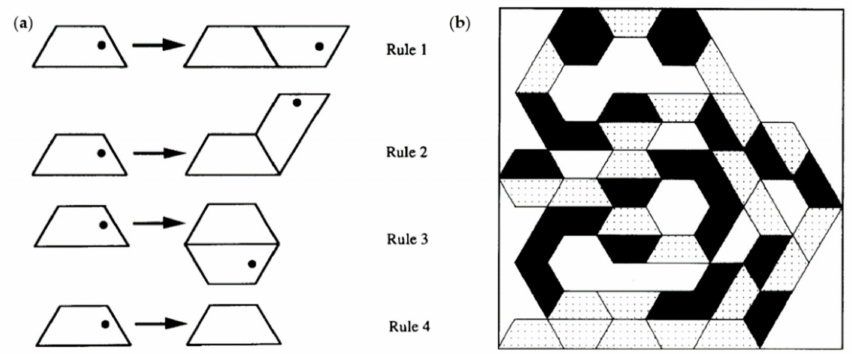
Figure 2. Snake-like shape grammars of half-hexagons: ( a ) Four simple shape grammar rules consisting of half-hexagons with a long base of one unit and a short base of one-half unit. Rule 4 is created to complete the final generated shape; ( b ) Final generated shape based on the snake-like shape grammar constrained to a 5 × 5 unit box with the condition of no pieces overlapping. The fill pattern indicated the applied rule, where a light fill points to rule 1, a medium fill points to rule 2 and a dense fill points to rule 3 (adapted from Cagan